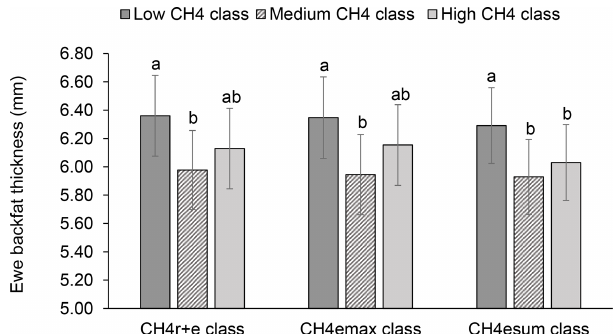
Figure 4. Least-squares means for ewe backfat thickness (BFT) depending on ewe mean CH 4 concentration during respiration class), maximal CH 4 concentration dur- and eructation (CH 4 r + e class), and sum of CH 4 concentrations ing eructation (CH 4 emax class) (model 1). Defini- per minute during eructation (CH 4 esum ≤ 25µLL − 1 ; CH tion of CH 4 classes: low CH 4 class: CH 4 4 r + e